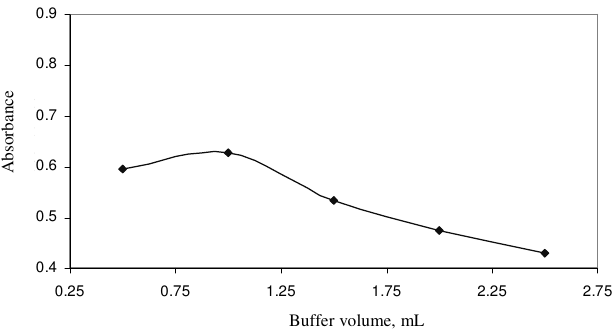
Figure 3. Effect of borate buffer pH 7.5 volume on the reaction between cupric chloride and 75 µ g mL -1